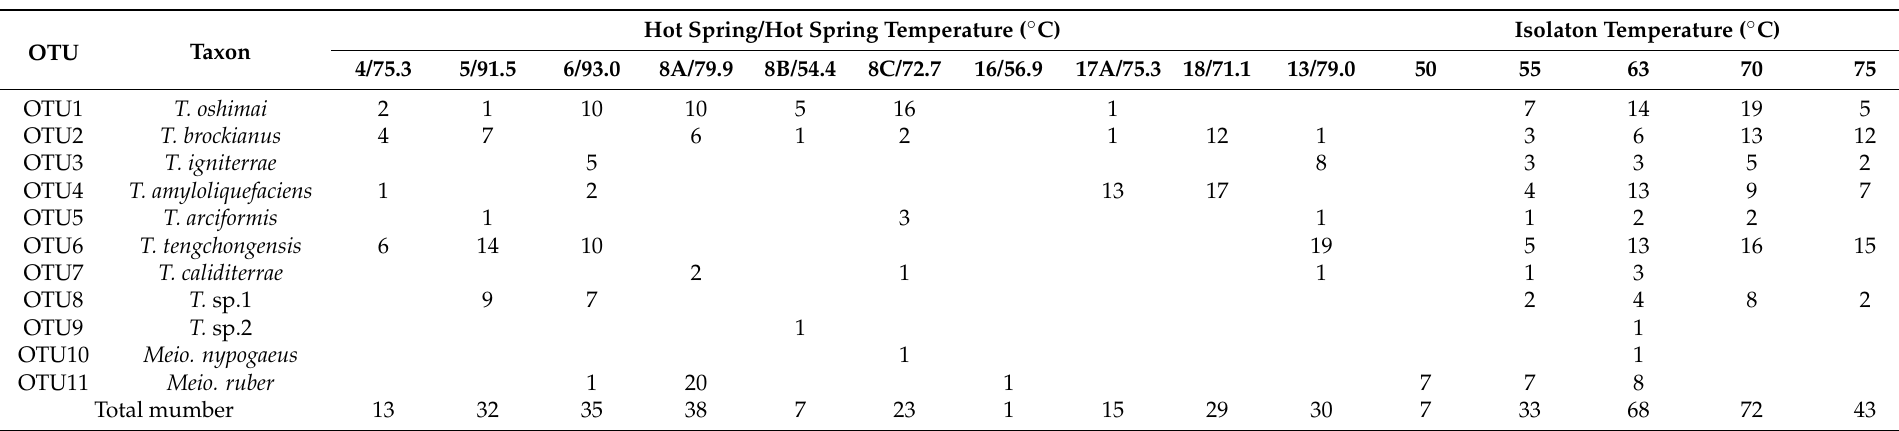
Table 2. Distribution characteristics of Thermus -like strains from different hot springs of four geothermal regions of southwestern Yunnan Province. OTU